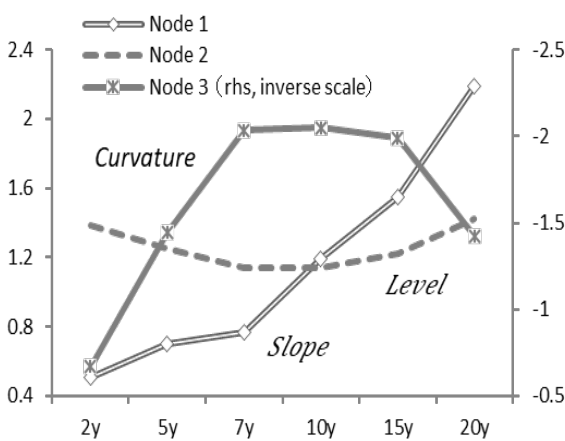
Figure 7. Coe ffi cients of the linear function output from the hidden layer (for three nodes). Figure 7. Coefficients of the linear function output from the hidden layer (for three nodes).